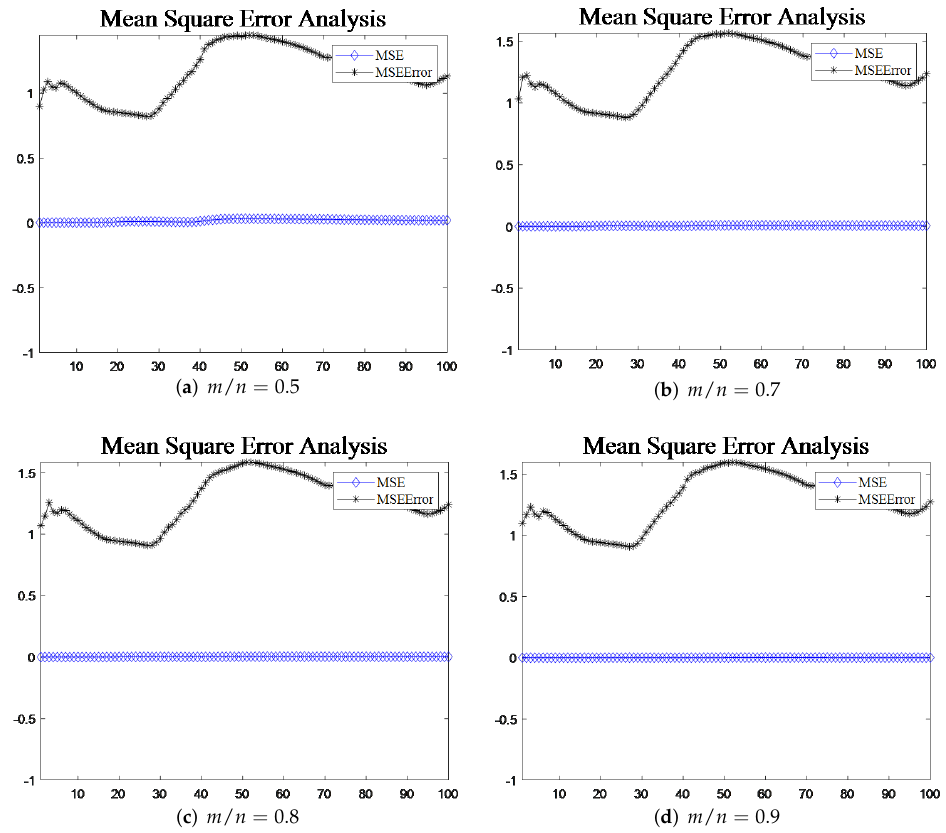
Figure 5. ( a ) Comparison of MSE and MSEError under m / n = 0.5. ( b ) Comparison of MSE and MSEError under m / n = 0.7. ( c ) Comparison of MSE and MSEError under m / n = 0.8. ( d ) Compari- son of MSE and MSEError under m / n =